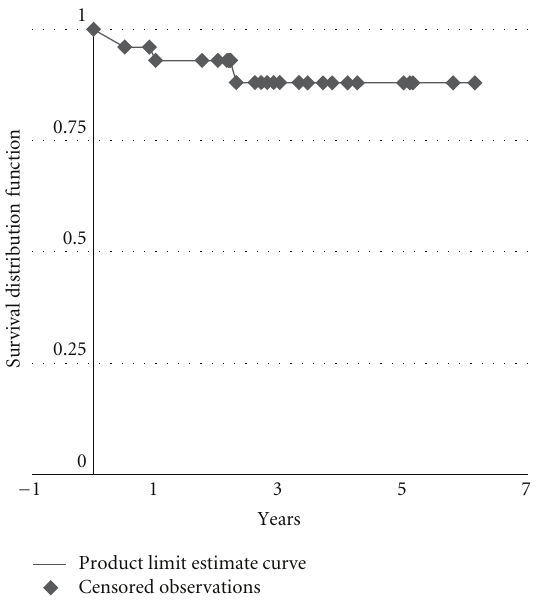
Figure 3: Overall survival in patients with advanced head and neck cancer treated with postradiotherapy neck